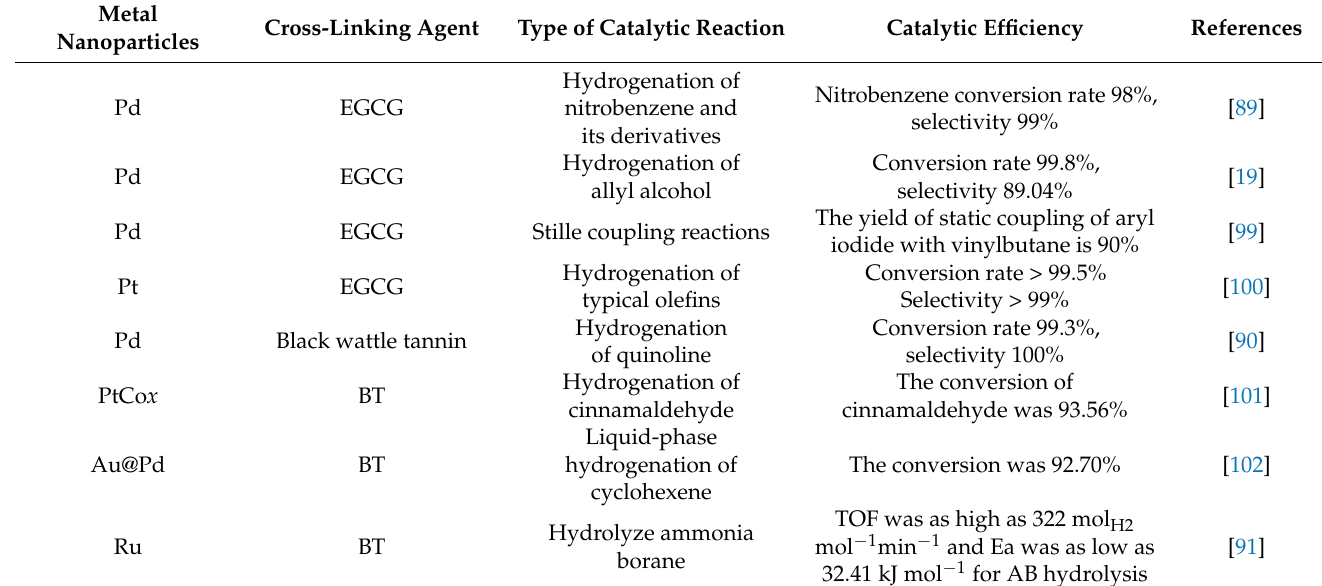
Table 1. Polyphenol cross-linking agents used to construct collagen-based